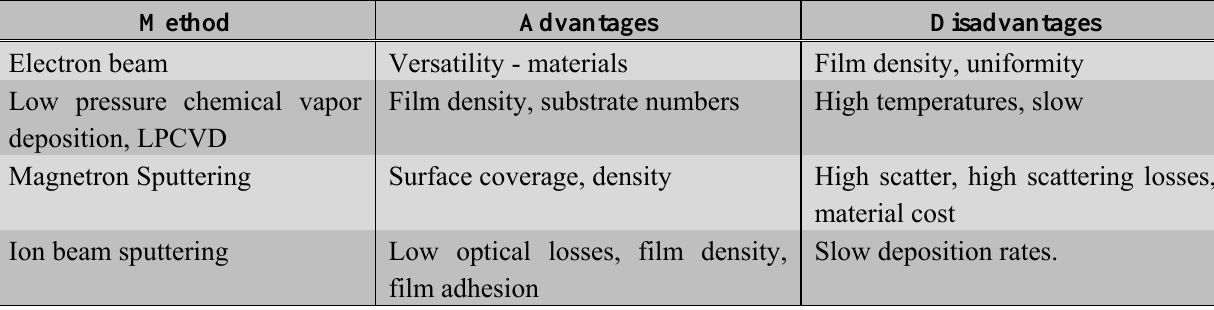
Table 1. Thin film deposition